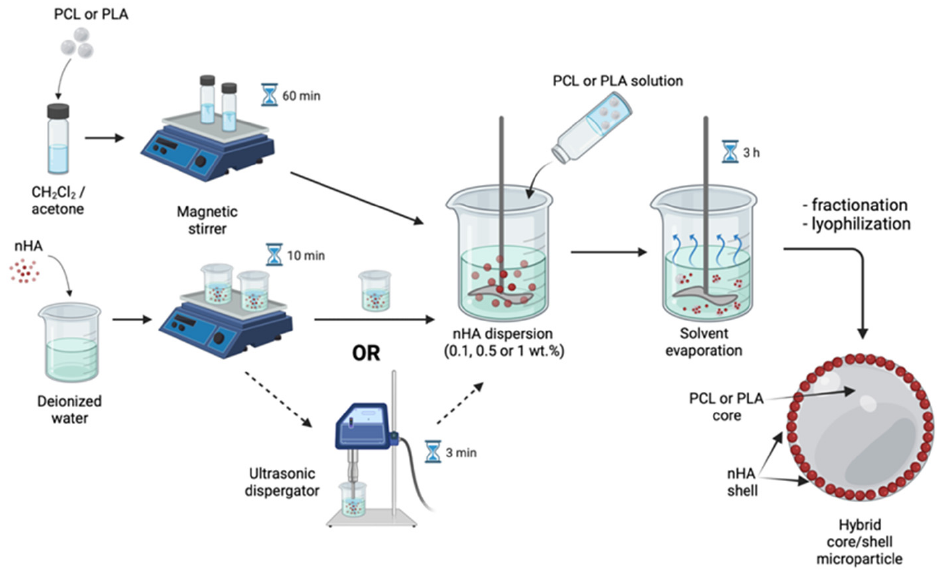
Figure 1. Solvent evaporation technique for core/shell microparticles fabrication. Created with BioRender.com (accessed on 8 September 2022).